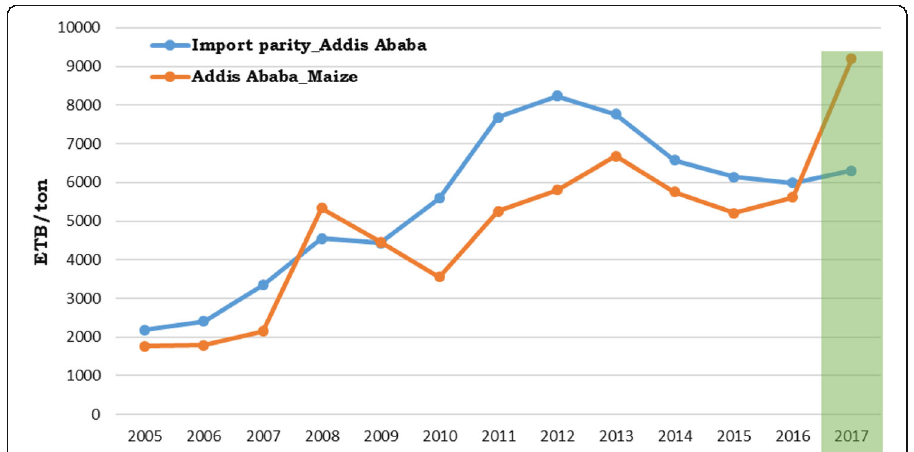
Table 9 Johansen cointegration tests between regional maize markets Market pairs Sample period Lag Nairobi-Addis